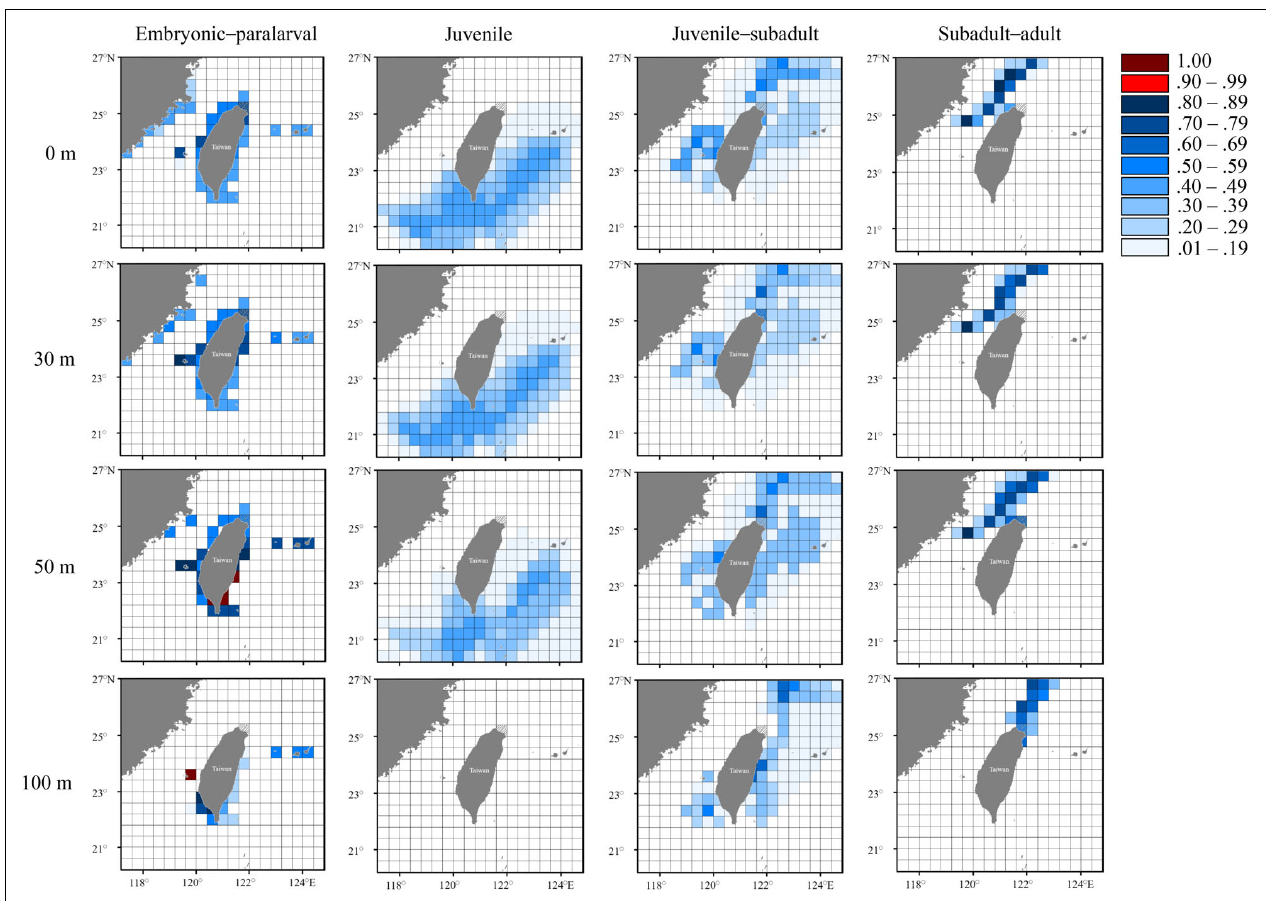
FIGURE 9 | Probability distribution based on experienced temperatures in S. lessoniana individuals of the autumn group at each life stage. The legend indicates the probability value of